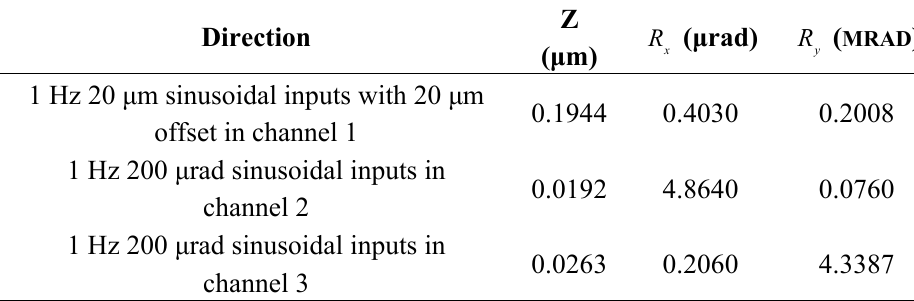
Table 2. Model prediction error if chirp inputs were